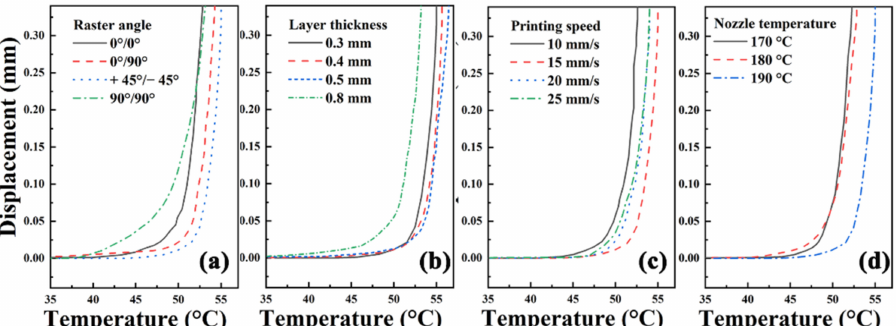
Figure 12. HDT curves of samples printed at various ( a ) rater angles, ( b ) layer thicknesses, ( c ) printing speeds and ( d ) nozzle